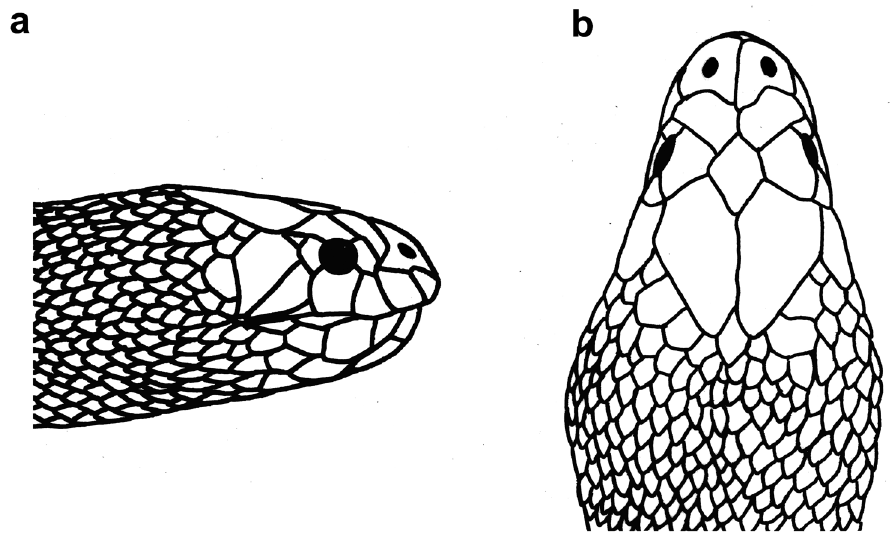
Figure 5. Head of Hydrophis schistosus : a lateral view b dorsal